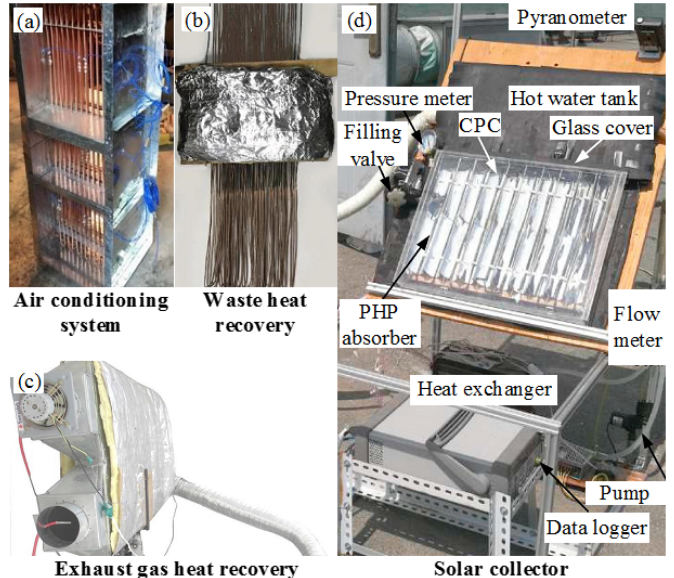
Figure 3. AGPHP heat recovery experiment: ( a ) Air conditioning system [57]. Barrak et al. (2020); ( b ) Waste heat recovery [58]. Liu et al. (2020); ( c ) Exhaust gas heat recovery [62]. Khodami et al. (2016); ( d ) Solar collector [63]. Xu et al. (2017).